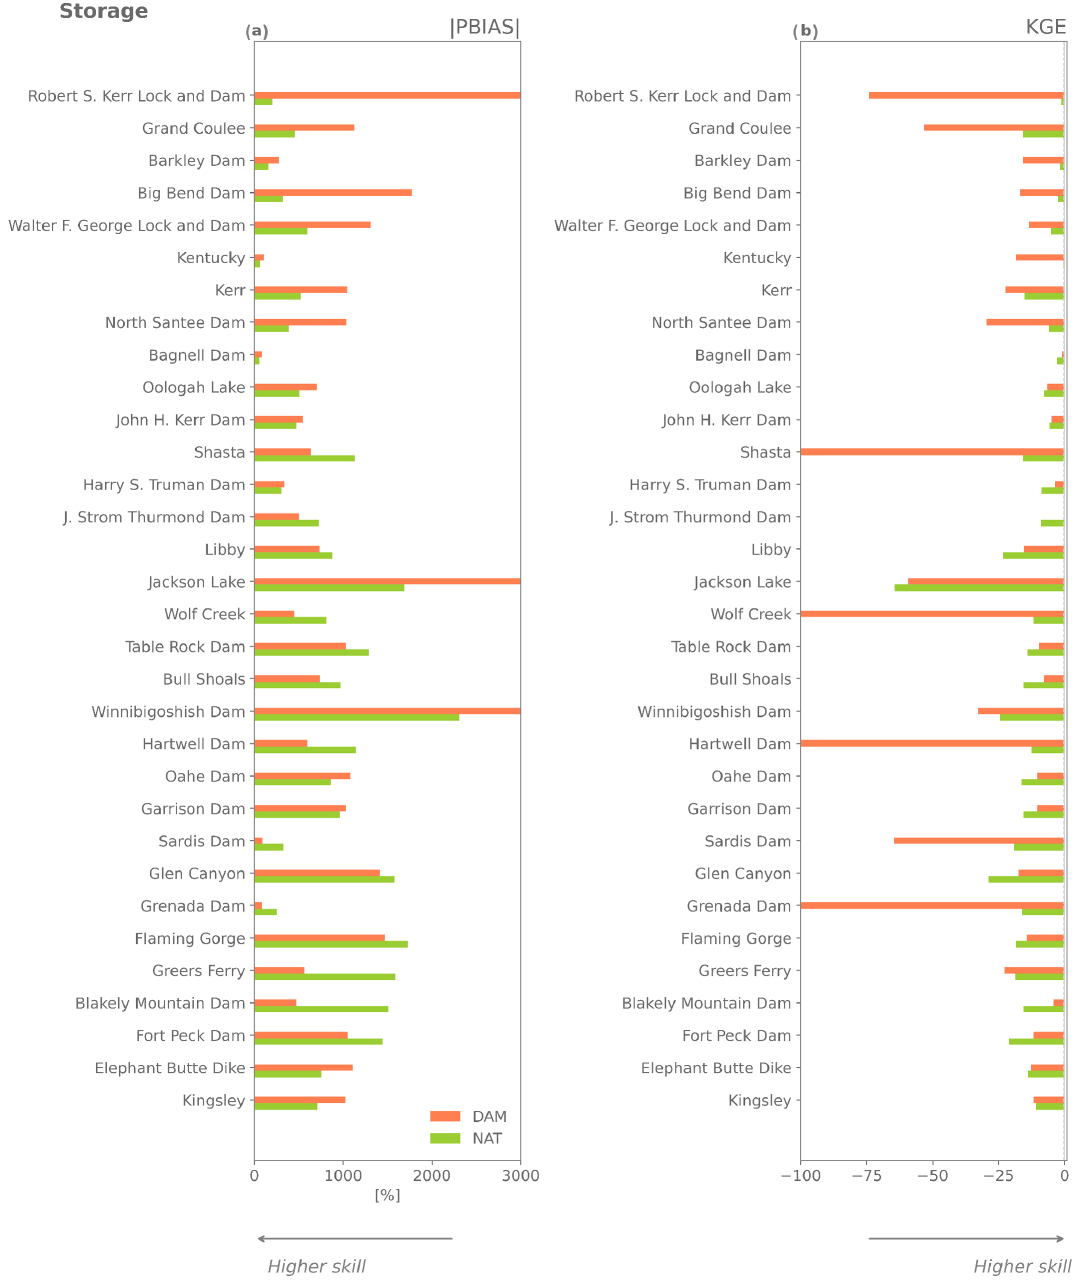
Figure A6. Performance of the global-scale mizuRoute simulations for storage compared to reservoir observations from the ResOpsUs dataset (Steyaert et al., 2022) using the absolute percent bias ( | PBIAS | , a ) and Kling–Gupta efficiency (KGE, b